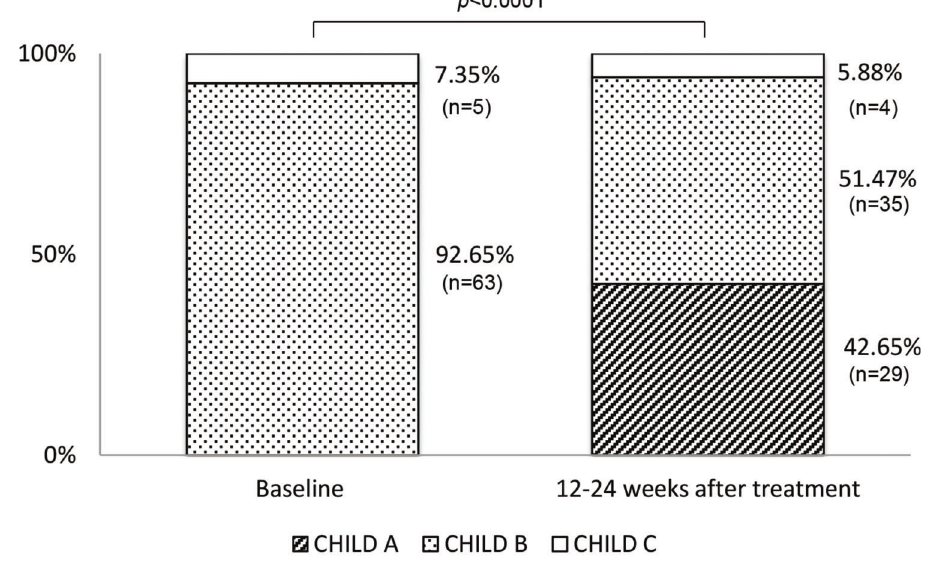
Figure 1 - Evolution of Child-Pugh score after successful